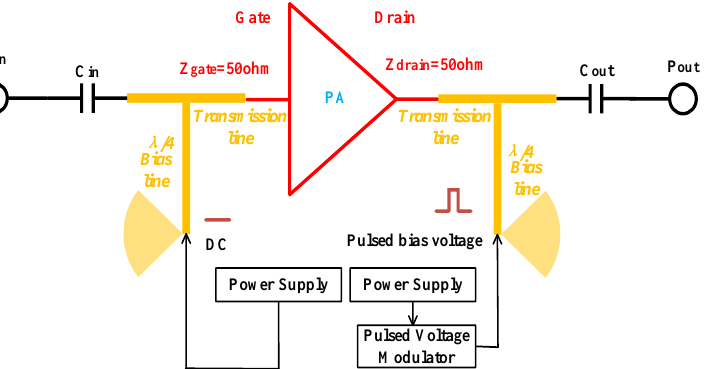
Figure 2. Relationship between the typical bias circuit, the power supply, and the power amplifier.